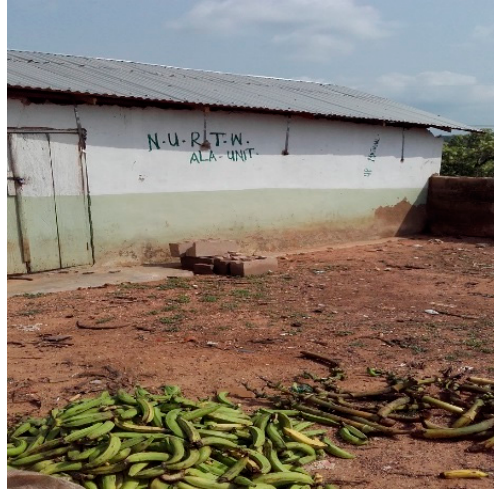
Figure 6. This is NURTW Ala Unit’s Office.